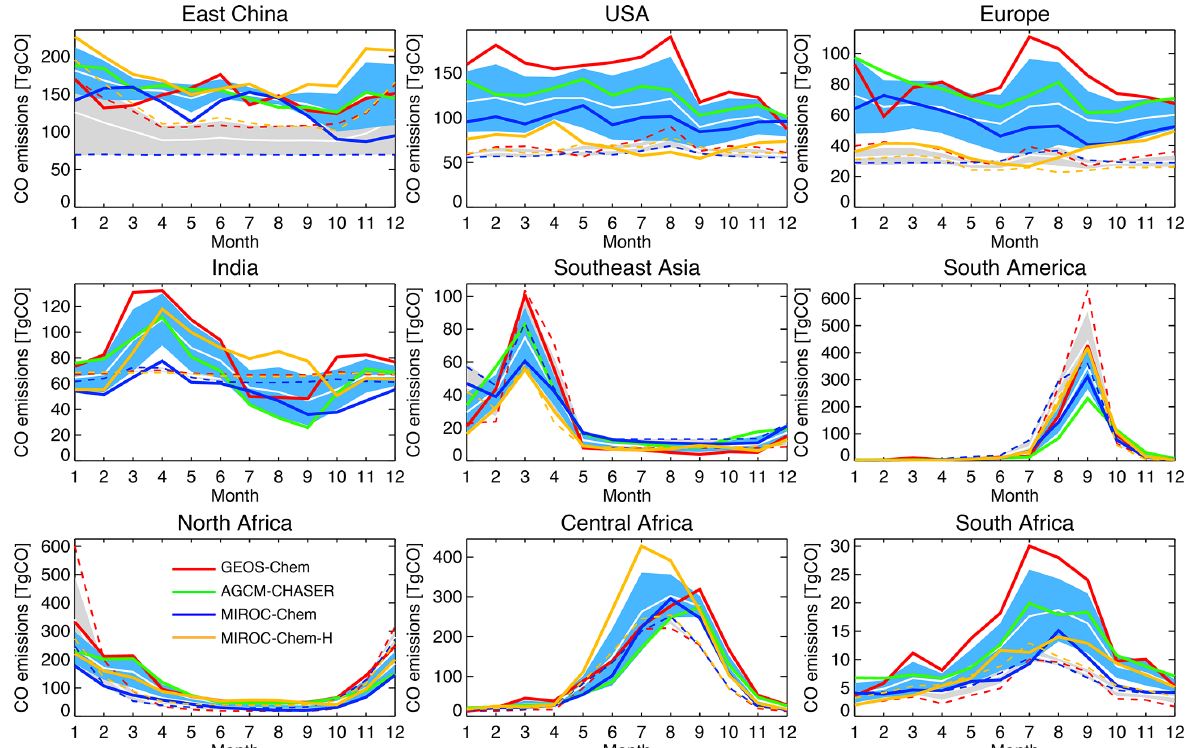
Figure 19. Same as in Fig. 18, but for monthly total regional surface CO emissions (TgCOyr − 1